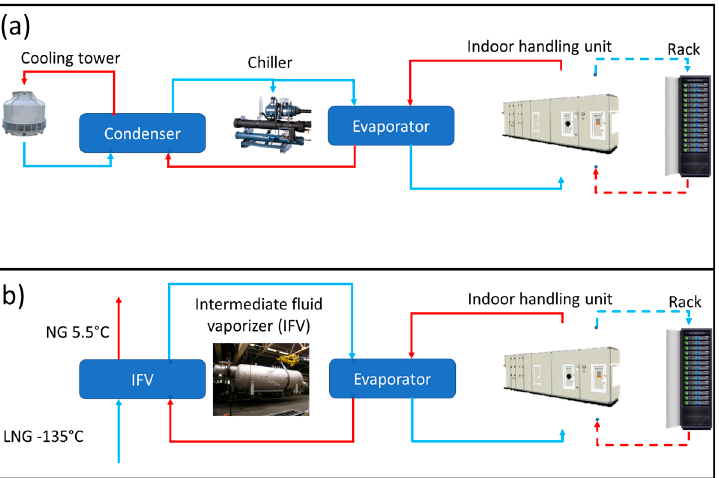
Figure 7. Cooling system for data centers: ( a ) conventional cooling system and ( b ) cooling system based on LNG cold energy utilization [115].